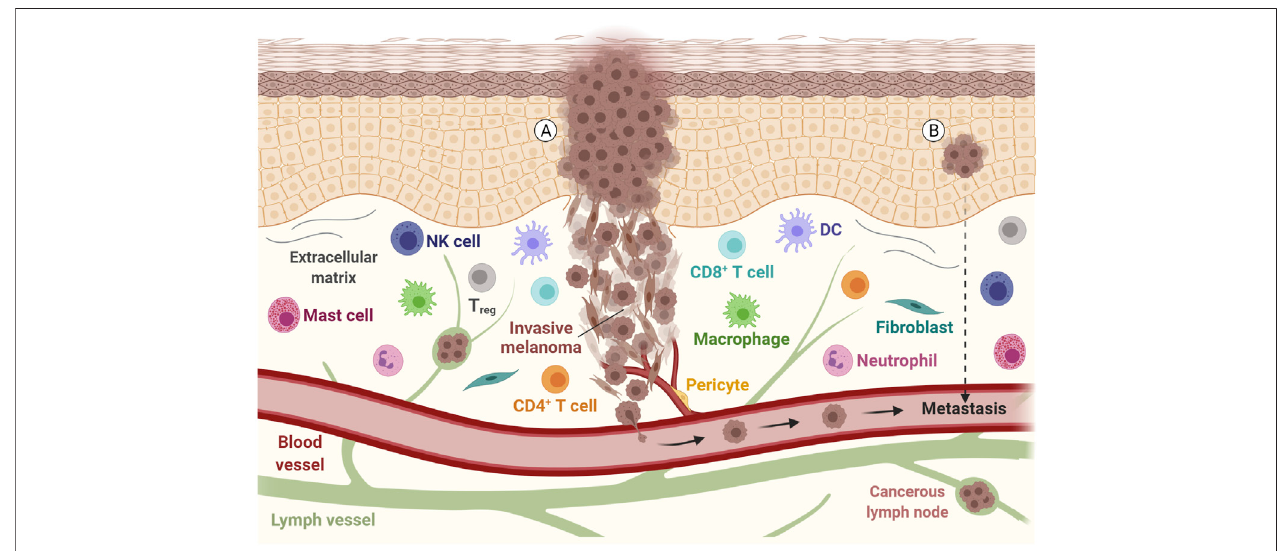
FIGURE 1 | Representation of a melanoma tumor during invasion and metastasis . Tumor cells with epithelial and mesenchymal-like morphology are shown, along with other components ofthe tumor microenvironment, such as the extracellular matrix, immune cells and fi broblasts. The communication between these components, with lymph vessels, blood vessels and tumor cells may allow the tumor to spread. (A) Metastatic disease is found in patients with clinically identi fi ed proliferating melanoma, (B) but also in patients with an undetected source of tumor cells or evident primary lesion. DC, Dendritic cell; NK, Natural killer; T reg , Regulatory T cell. Adapted from “ Melanoma Staging ” , by BioRender.com (2021). Retrieved from